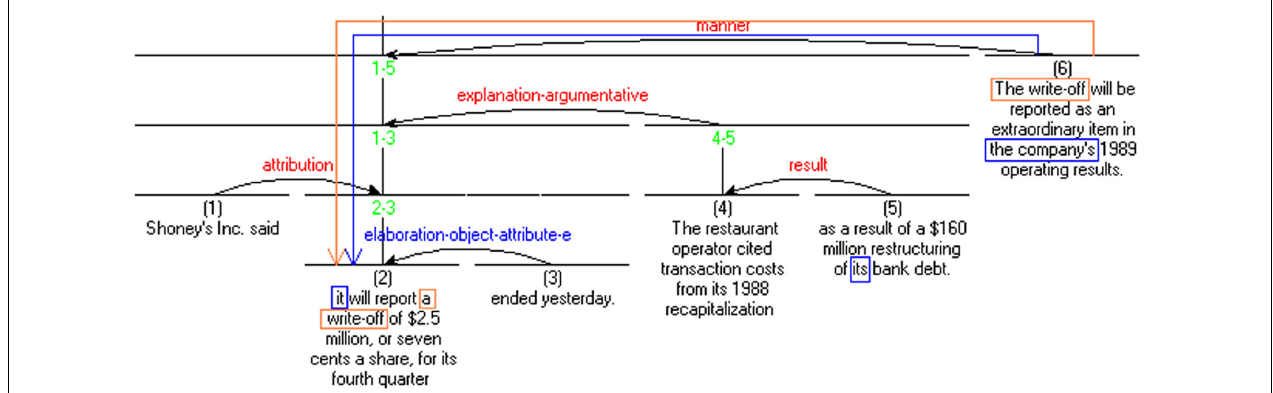
FIGURE 2 | Example of a rhetorical graph from RST Discourse Treebank with examples of RhD computation. The referent ‘the write-off’ is mentioned in units #2 and #6. Linear distance from #6 back to #2 equals 4. Rhetorical distance (RhD) from #6 to #2 is just 1, as these two nodes are immediately connected to each other in the RST graph, and one only needs one horizontal step along the graph to reach #2. The anaphor the company found in unit #6 has its closest linear antecedent in unit #5. However, its closest rhetorical antecedent is again found in #2, directly connected to the anaphor unit #6. Arrows indicate paths along the RST graph one needs to travel to reach an